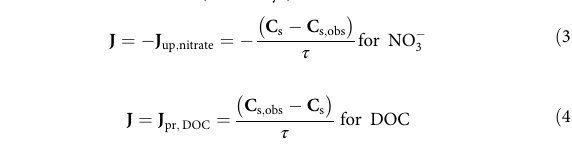
aging applying 15 ‰ for both X and Y axes